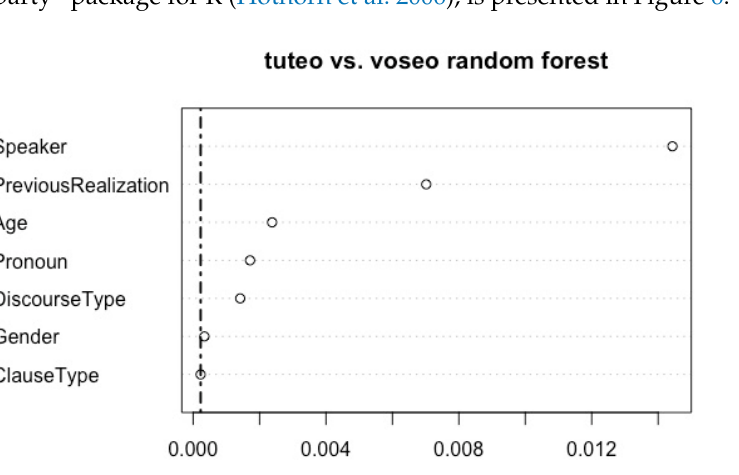
Figure 6. Variable importance ranking from random forest for voseo vs. tuteo.